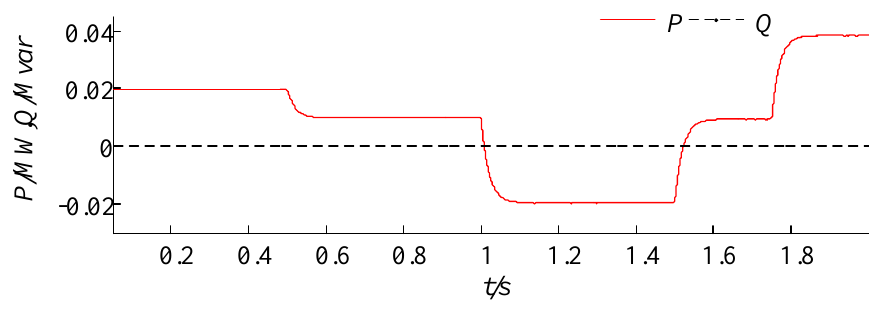
Figure 6. Output active and reactive powers of the MSC.